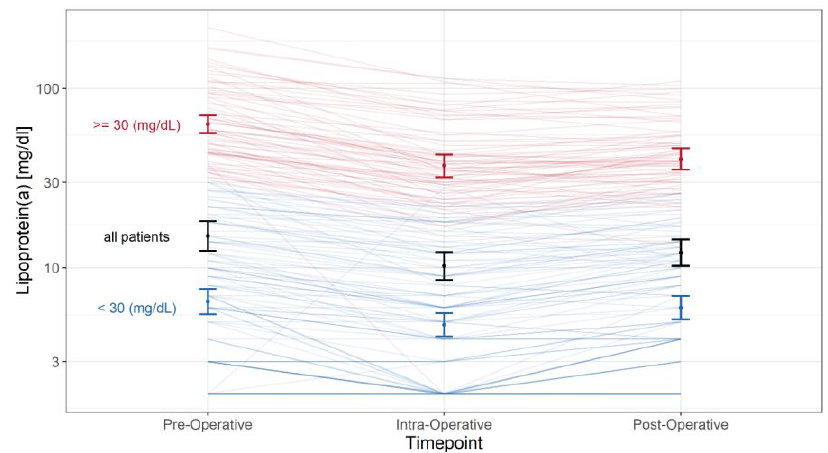
Figure 2. Time series of Lp(a): geometric means and their associated 95% confidence intervals are shown for all patients (in black), high-Lp(a) patients (preoperative Lp(a) ≥ 30 mg/dL; in red), and low-Lp(a) patients (preoperative Lp(a) <30 mg/dL; in blue).